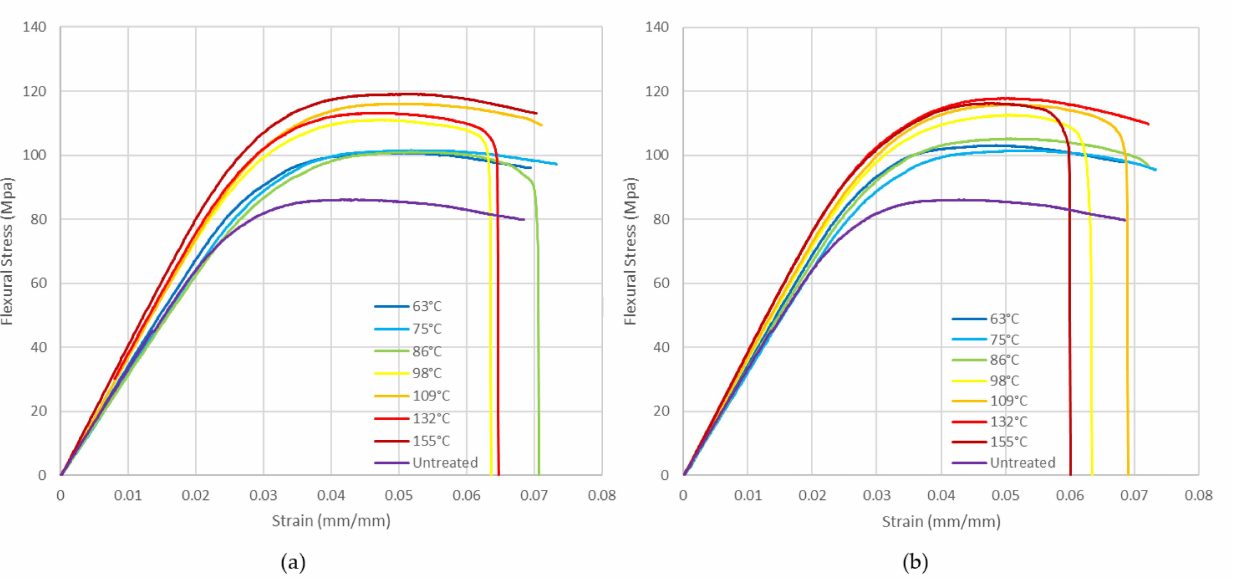
Figure 18. PLA flexural stress vs. strain at different annealing temperatures: ( a ) with mould; ( b ) without